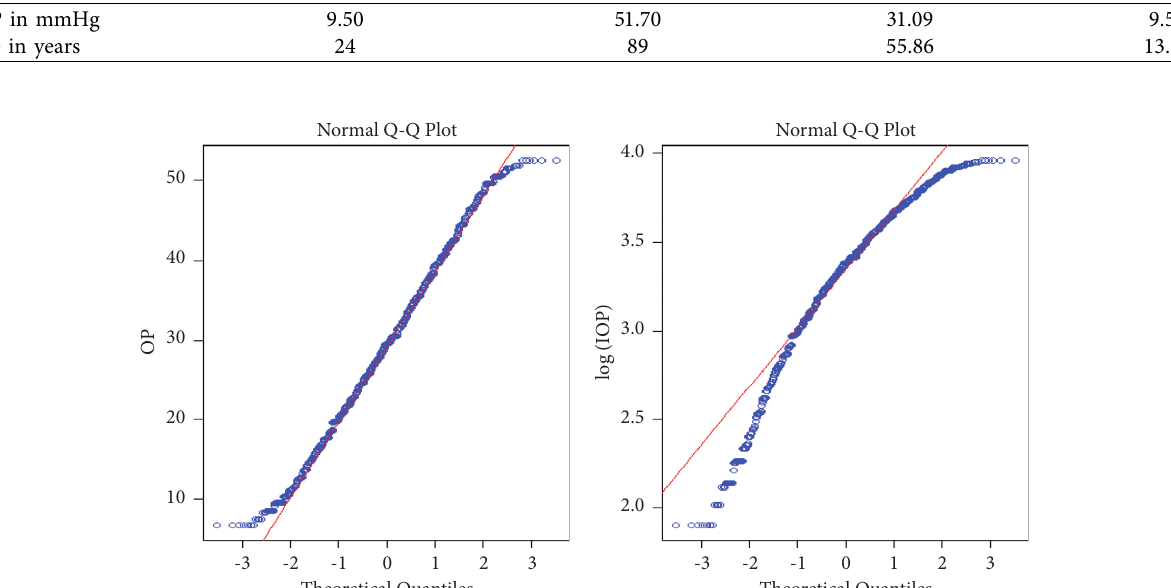
Figure 1: Normal Q-Q plot of original IOP (a) and log of IOP (b) for glaucoma